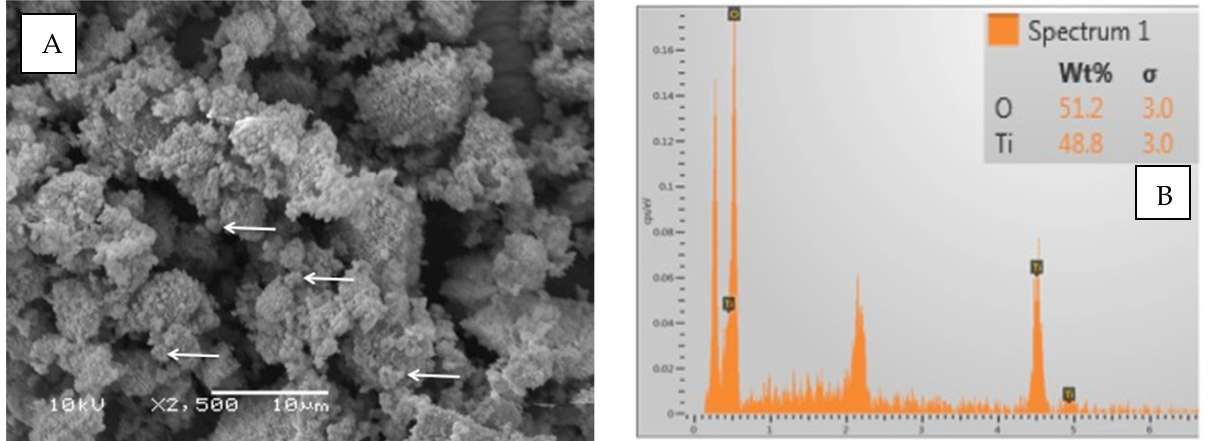
Figure 3. ( A ) SEM image of TiO 2 . The particles had irregular and spherical shapes. The particle size was approximately 500–1000 nm (arrows denote small particles). ( B ) The representative EDX graph shows almost equal quantities of Ti and O in the tested powder.